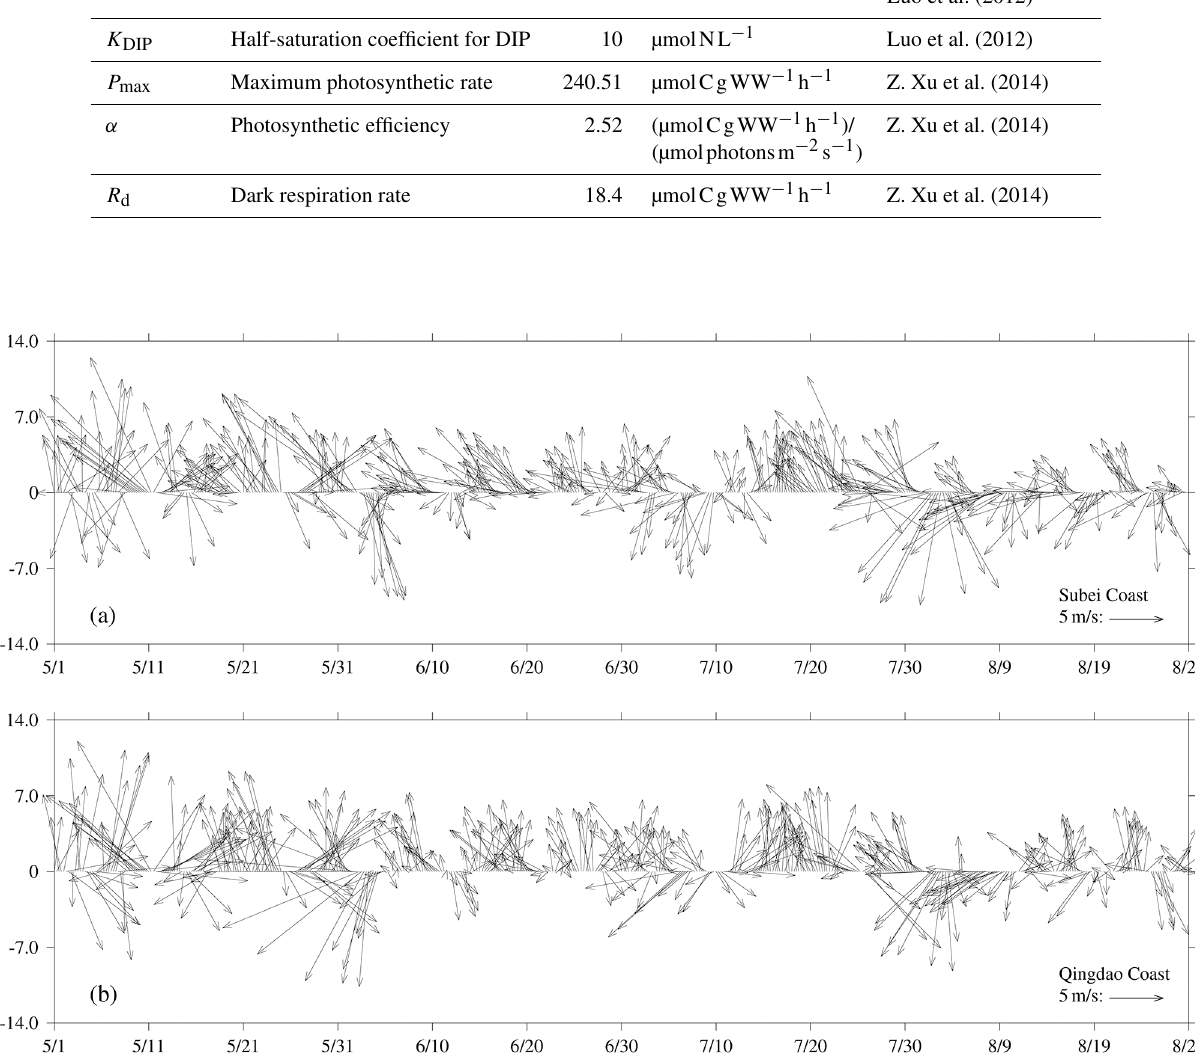
Geosci. Model Dev., 14, 6049–6070,